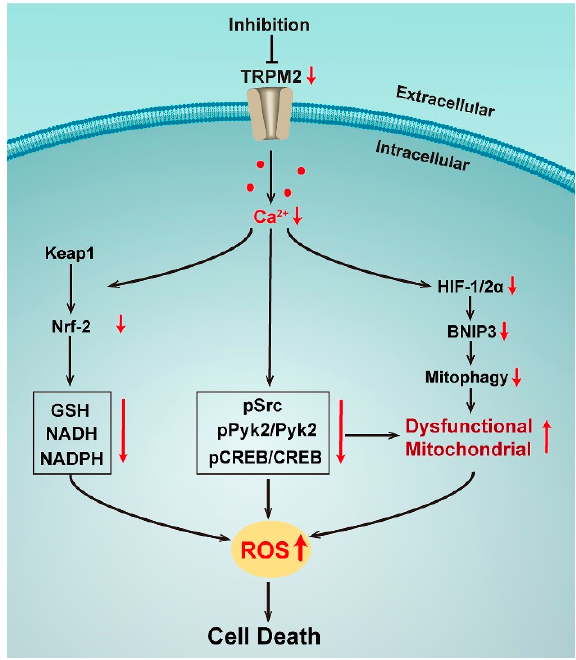
Figure 2. Effects of TRPM2 inhibition in neuronblastoma. Figure 2. E ff ects of TRPM2 inhibition in